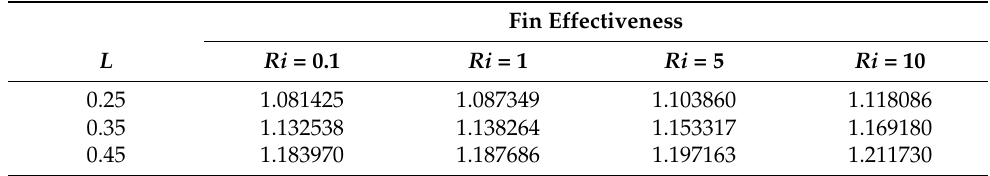
Table 3. Fin effectiveness for various Ri and L at Ha = 20 and Re =